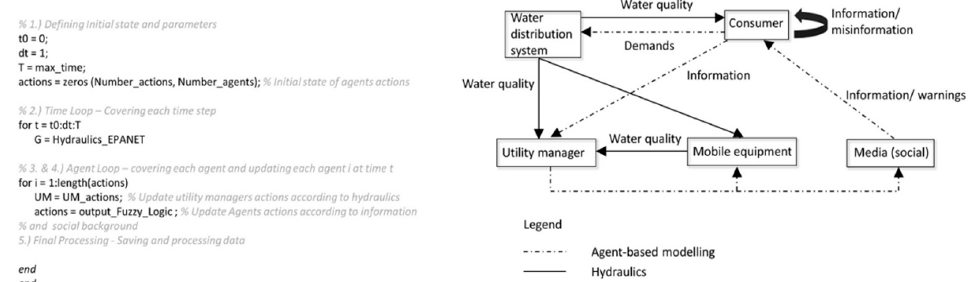
Figure 1. Pseudocode ( left ) and conceptual flowchart ( right ) of the agent-based modelling frame- work.